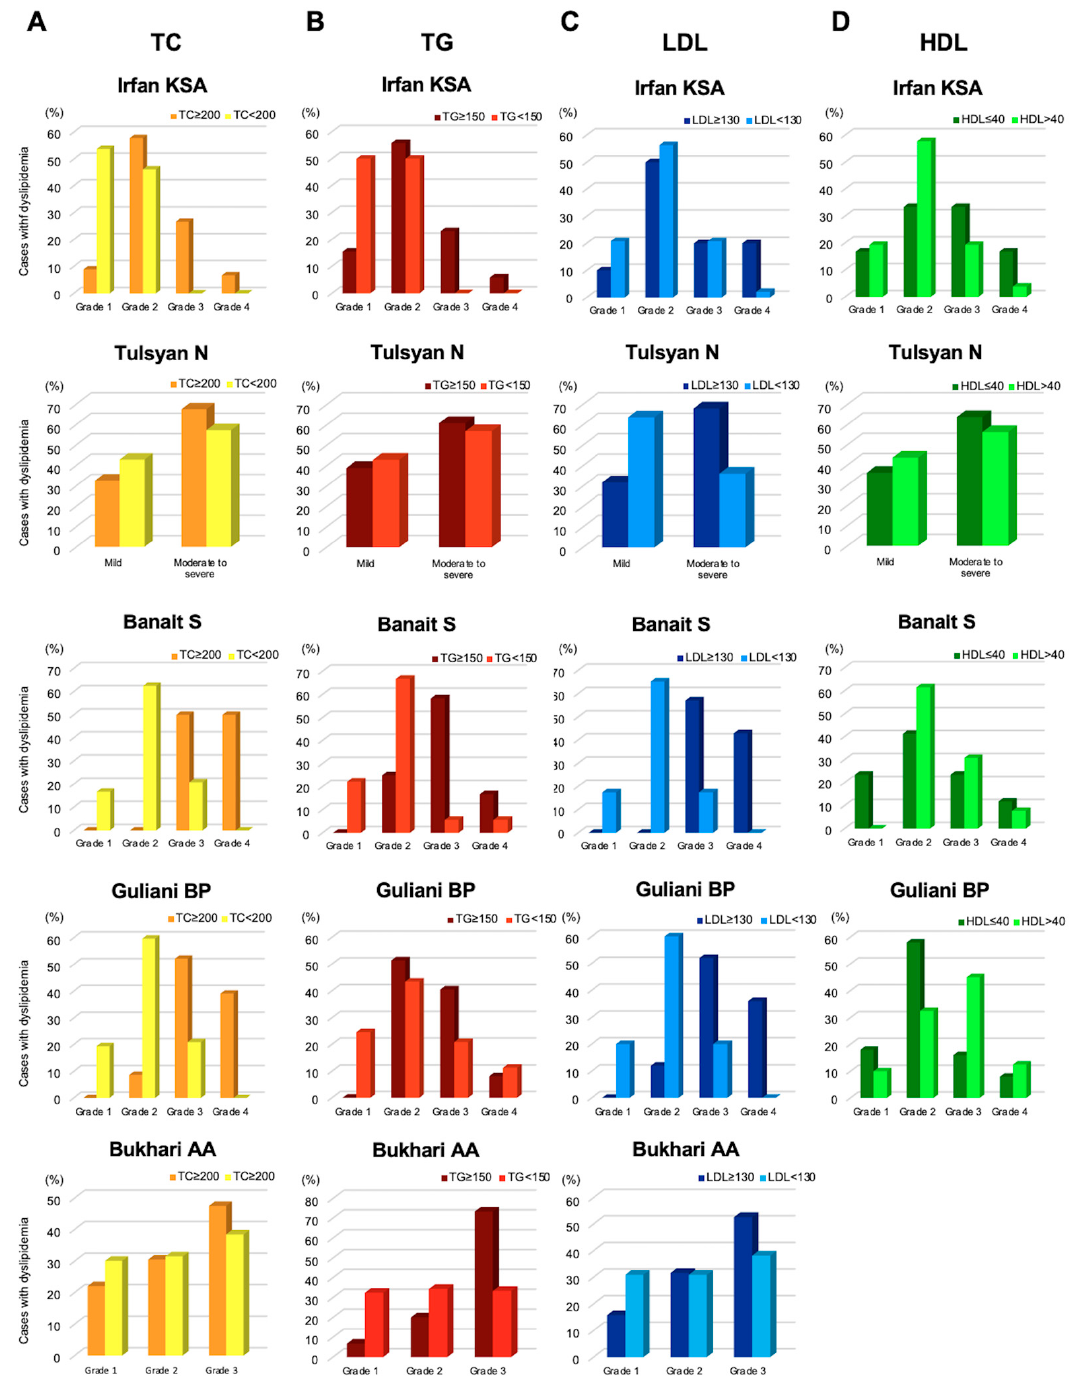
Figure 3. Severity of MGD and dyslipidemia. ( A ). Cases with total cholesterol (TC) ≥ 200 mg/dL according to the severity of MGD, ( B ). Triglyceride (TG) ≥ 150 mg/dL, ( C ). Low-density lipoprotein (LDL) ≥ 150 mg/dL, ( D ). High-density lipoprotein (HDL) ≤ 40 mg/dL. Reproduced from [34] and [35], with permission from Ubiquity Press, 2023, [28] with permission from Medknow Publications, 2023, and [26] with permission from Wolters Kluwer Health, Inc, 2023.